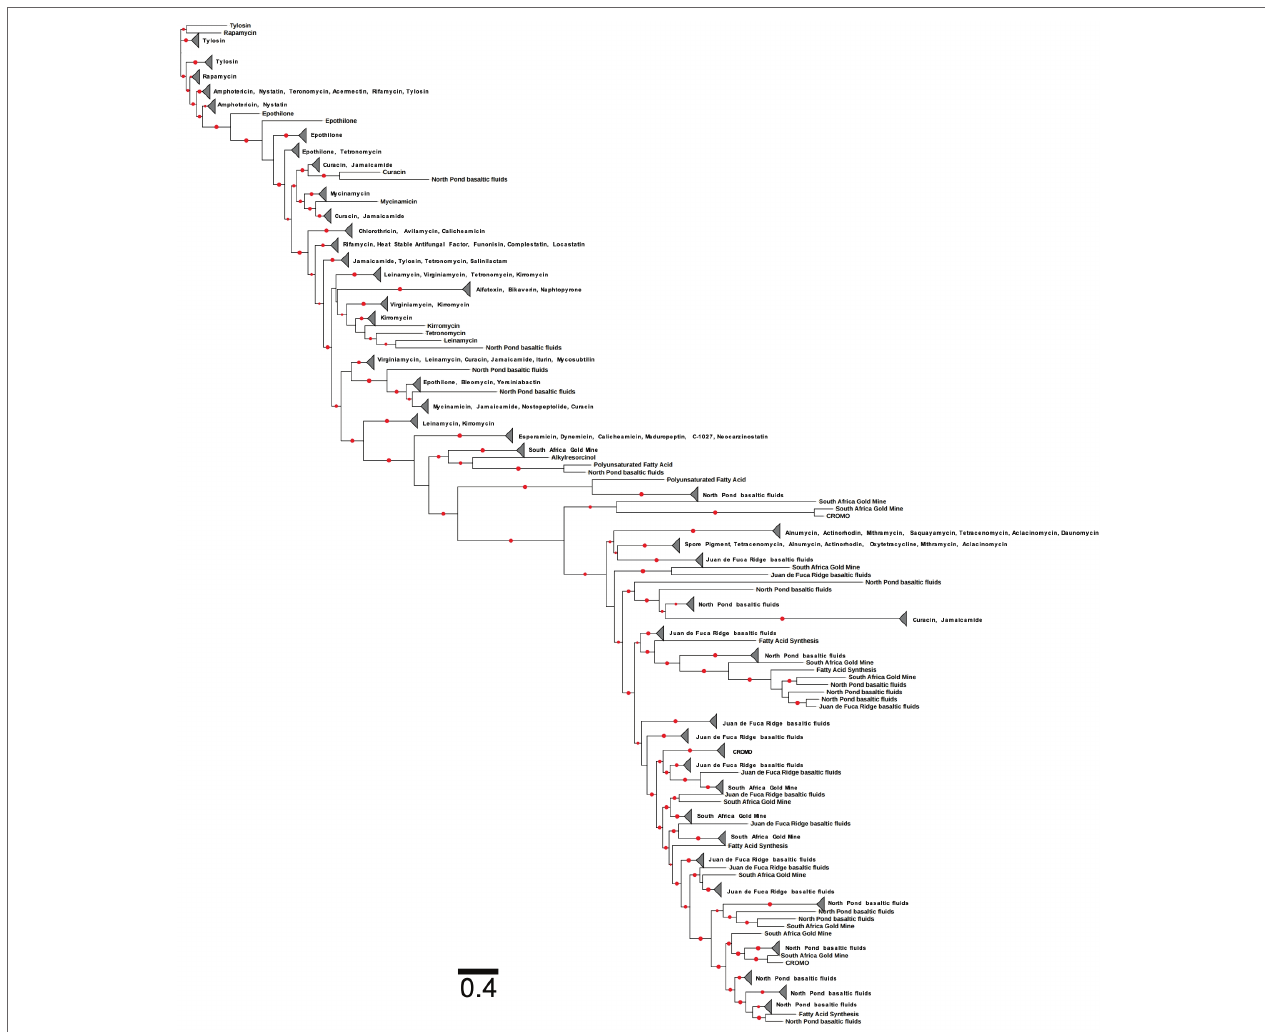
FIGURE 5 | Phylogenetic tree of the ketosynthase domain of the PKS gene including sequences from terrestrial and marine deep subsurface sites. The reference sequences are from the Natural Product Domain Seeker (NaPDoS) repository. The alignment and tree were built using the NaPDoS pipeline (Ziemert et al., 2012). Red dots indicate bootstrap values greater than